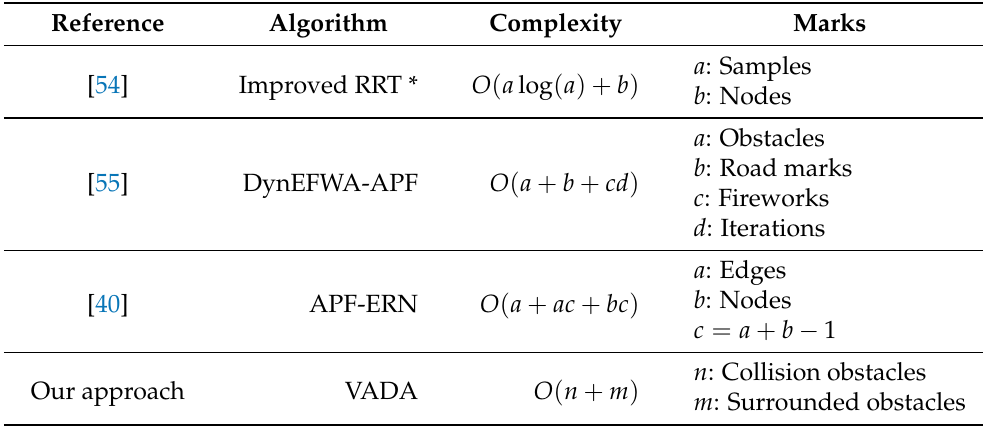
Figure 6. Flowchart of proposed local path planner. Table 2. Computational complexities of some local path planning algorithms.